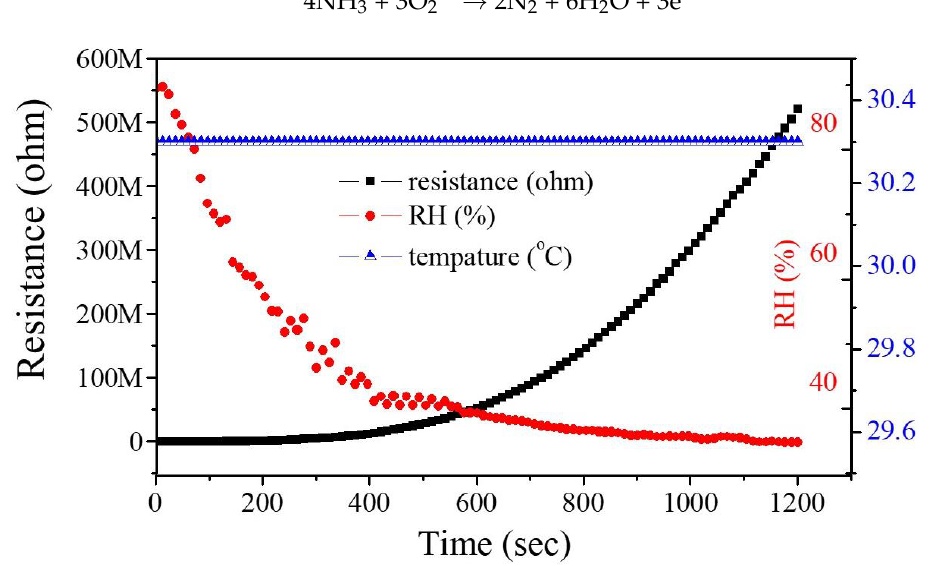
Figure 9. The effect of ambient temperature and humidity on the ZnO-NPs/MEMS gas